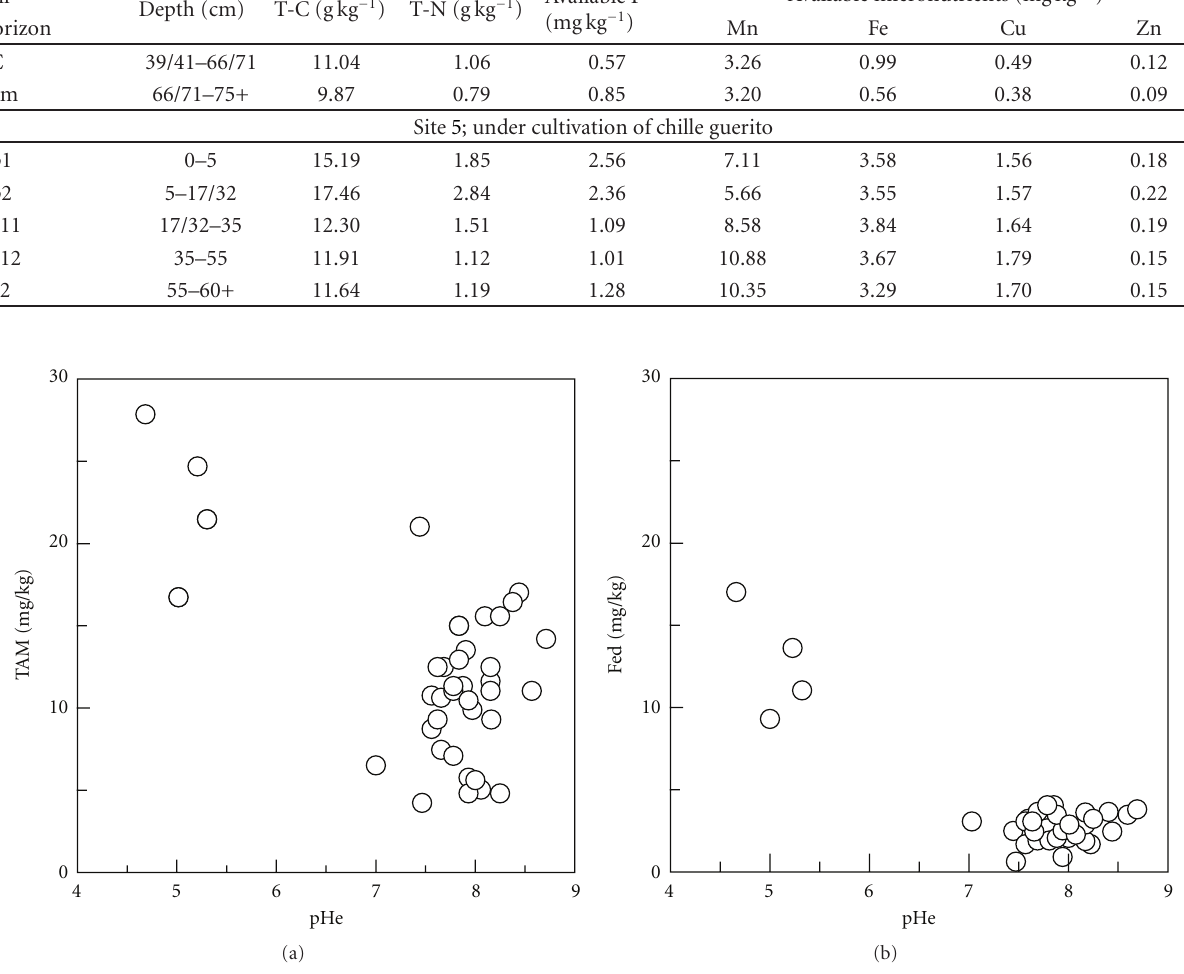
Figure 4: Relationship between pHe and available micronutrients. (a) Relationship between pHe and TAM (%). (b) Relationship between pHe and Fed